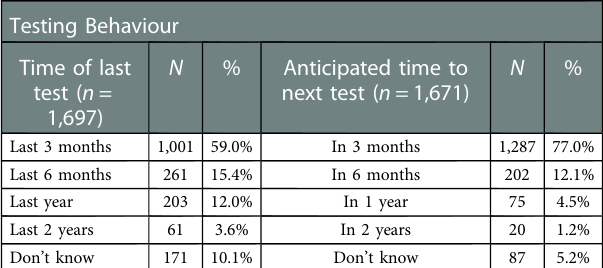
TABLE 4 Previous testing behaviour and intention to test